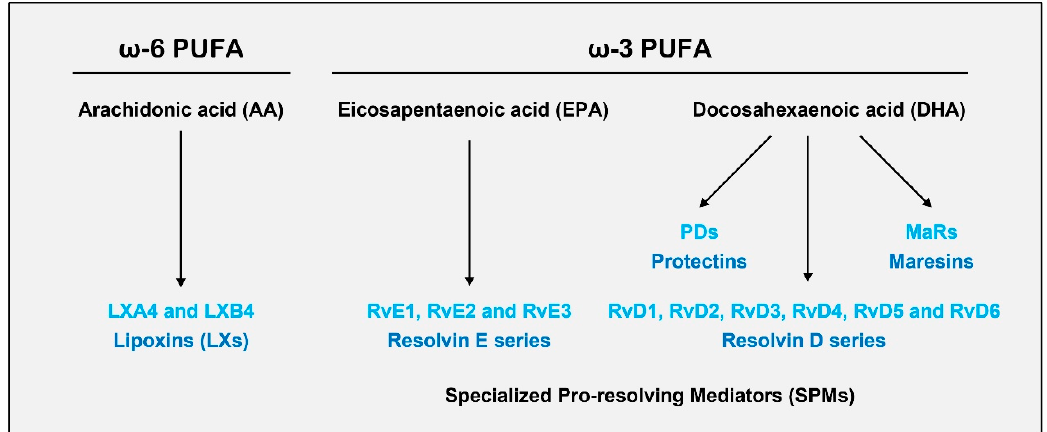
Figure 1. Biosynthesis of specialized pro-resolving mediators (SPMs) derived from omega-3 and omega-6 polyunsaturated fatty acids (PUFAs).